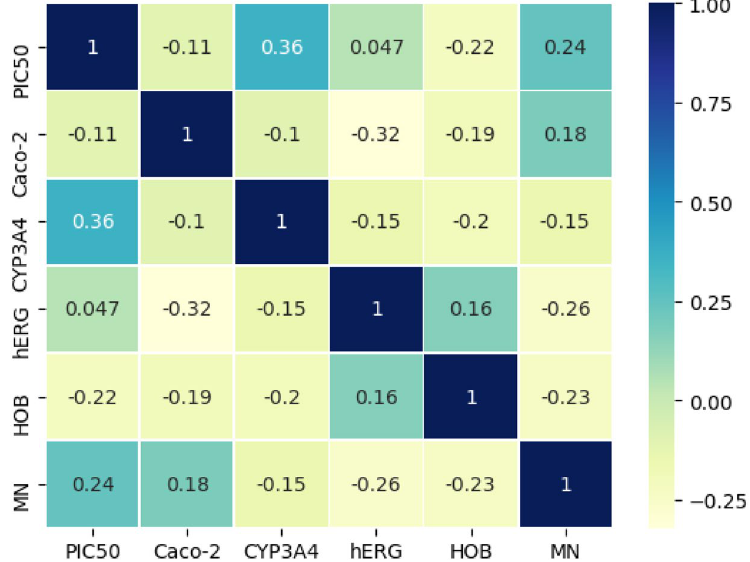
Figure 3. Optimization target correlation analysis.